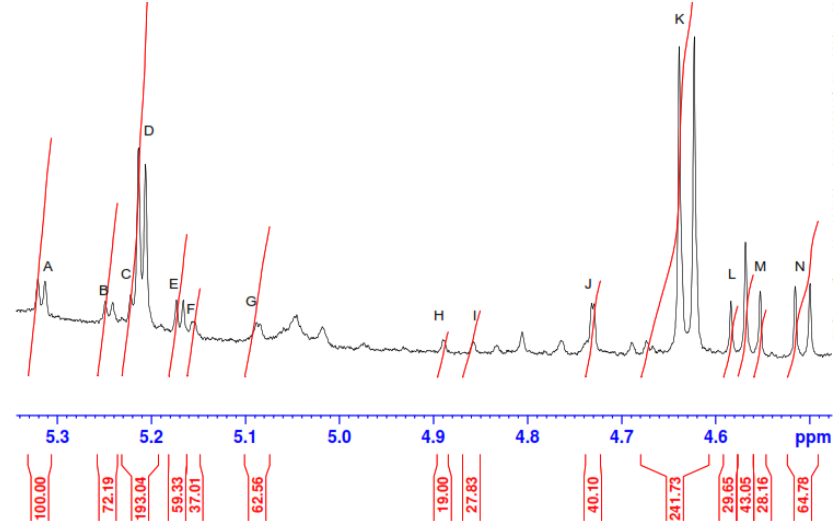
Figure 1. 1 H NMR green tea leave residue after hot water extraction. Signal: A, α -glucoronic acid; B, α -galactose; C, α -arabinose; D, α -glucose; E, α -xylose; F, α -mannose; G, α -rhamnose; H, β -mannose; I, β - rhamnose; J, β - glucoronic acid; K, β - glucose; L, β - galactose; M, β - xylose; N, β -arabinose.